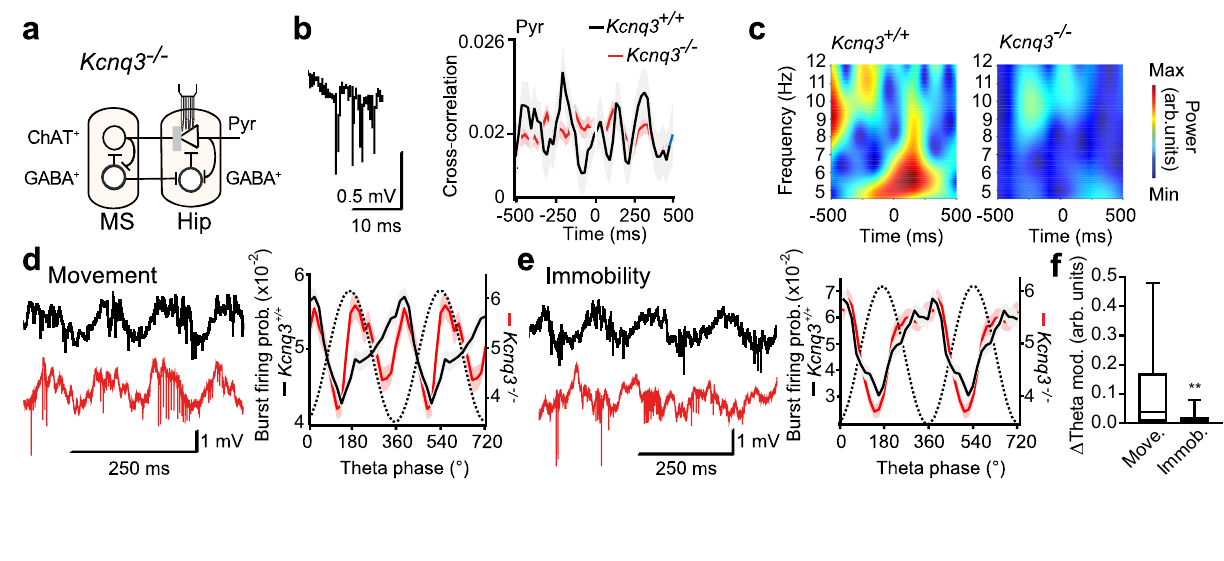
Fig. 2 Theta-rhythmic coordination of spike bursts during spatial navigation involves Kcnq3-containing M-channels. a Scheme: impaired modulation (gray bar) of hippocampal (Hip) pyramidal cells (triangle, Pyr) via MS cholinergic neurons (circle, ChAT + ) in Kcnq3 − / − mice. Modulatory effects of cholinergic inputs are in part mediated by muscarinic receptor-mediated inhibition of Kcnq3-containing channels 19 . Circles, GABA + , inhibitory cells. b Example complex spike burst recorded in CA1 pyramidal layer (left) and cross-correlation of burst times between pyramidal cells (right) during theta oscillations (mostly during running, mean ± SEM (shaded bonds) of 154 cell pairs with joint fi ring of bursts out of 625 recorded pairs (25%) from 6 Kcnq3 + / + mice, black; 854 pairs with joint fi ring of bursts out of 1403 recorded pairs (61%) from 4 Kcnq3 − / − mice, red; χ ²(1, n = 2028) = 227.0, p <0.0001, χ ² — test). The color code is used for the entire fi gure. c Spectrograms of average correlations between pairs of cells shown in ( b ), revealing theta-frequency coordination of bursts in Kcnq3 + / + ( p = 0.007, permutation test) but not in Kcnq3 − / − ( p = 0.239) mice. d , e Burst probability as a function of theta oscillation phase during spatial navigation ( d , n = 191 cells from 6 Kcnq3 + / + mice; n = 209 cells from 4 Kcnq3 − / − mice) and alert immobility ( e , Kcnq3 + / + : n = 124 cells; Kcnq3 − / − : n = 210 cells). Dotted line: reference oscillation cycle. Left: representative signals (1Hz – 10kHz) showing theta oscillations and neuronal discharge during spatial navigation ( d ) and alert immobility ( e ) in Kcnq3 + / + and Kcnq3 − / − mice. As typical for the mutant, a long burst in ( d ) starts close to the theta peak. Data are presented as mean ± SEM. f Difference of burst probability between genotypes during navigation ( d , top) and alert immobility ( e , top, independent squared differences for n = 20 phase bins/behavior, ** p = 0.0049, t test). The center line indicates the median, the top and bottom edges indicate the 25th and 75th percentiles, respectively, and the whiskers extend to the maximum and minimum data points. Arb. units, arbitrary units. See also Supplementary Information, Statistical Analysis (Fig. 2b – with single spikes 51 . In line with those results 51 , which were obtained in rats, place fi elds of bursts and of single spikes in Kcnq3 + / + mice were overall correlated (z-transformed Pearson ’ s r, arena: 0.63 ± 0.09, n = 43 cells; track: 0.46 ± 0.05, n = 68 cells). The spatial coordination was particularly high in a fraction of cells (Supplementary Fig. 5a,b).